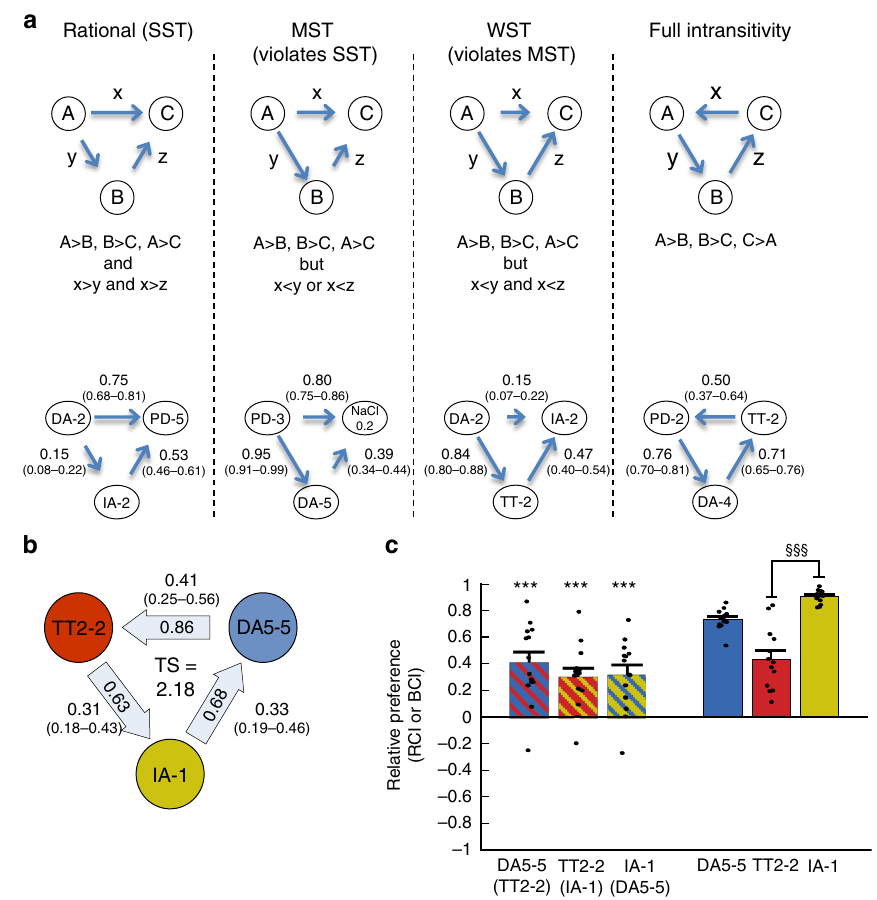
Fig. 2 C. elegans worms violate the transitivity principle. a Levels of violations of stochastic transitivity (top, schematic; bottom, examples for putative sets). Arrows indicate the direction of preference, where A → C means that A is preferred over C. For each pairwise comparison, number of experimental repeats is provided in the order of {left pair, right pair, top pair}. Left column: a transitive cycle is maintained (also known as strong stochastic transitivity, SST, see methods, N = 7,3,2). Middle columns: in moderate (MST) and weak (WST) stochastic transitivity, the hierarchy order is preserved, but preference magnitude of the direct interaction between the strongest option in the hierarchy and the weakest option is lower than either (MST, N = 2,6,2) or both (WST, N = 3,4,7) of the two other interactions. Right column: full intransitivity, manifested by a directed cycle within the triple-set options ( N = 3,3,1). The values next to the arrows indicate the directional preference magnitude (measured as Relative Chemiotaxis Index, RCI) with 95% con fi dence intervals in parentheses (for detailed explanation of calculating con fi dence intervals see methods). Numbers next to the stimulus specify its dilution (e.g., TT2 – 2 means TT dilution of 2 × 10 – 2 ). b A robust full intransitivity is found in the triple-set TT2 – 2/DA5 – 5/IA-1. Pair scores ( log P ð A = B Þ probability of choosing A over B), are indicated inside the arrows, and the cycle ’ s triple-score (TS) is the directional sum of the Pair Scores (see methods). Values next to the arrows are the RCI ’ s with 95% con fi dence intervals in parentheses. c The three right-side bars denote the basal preference to the stimulus (BCI). The three left-side (striped) bars denote the preference relationships (RCI) of top stimulus vs the stimulus in parenthesis. Notably, for full intransitivity, all three values should be positive (or negative). Note that TT2 – 2 outperforms IA-1 in spite of its lower BCI. N = 14 and N = 13 experimental days for the RCI and the BCI measurements, respectively. Scattered dots are the mean chemotaxis indexes of plates in each experimental day. §§§ p < 0.001 ( t test). *** indicates means are larger than 0 at p < 0.001, ANOVA. Error bars denote